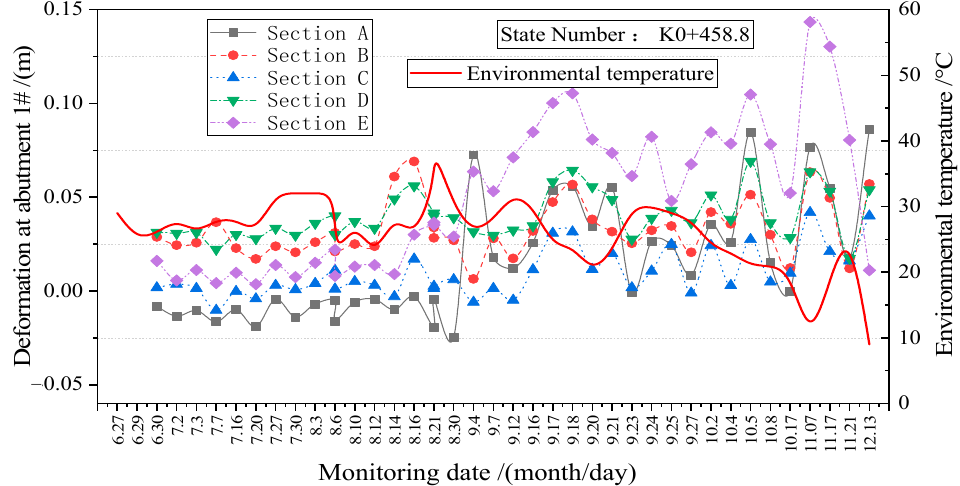
Figure 16. Deformation monitoring historical curves of the box girder at abutment #1.